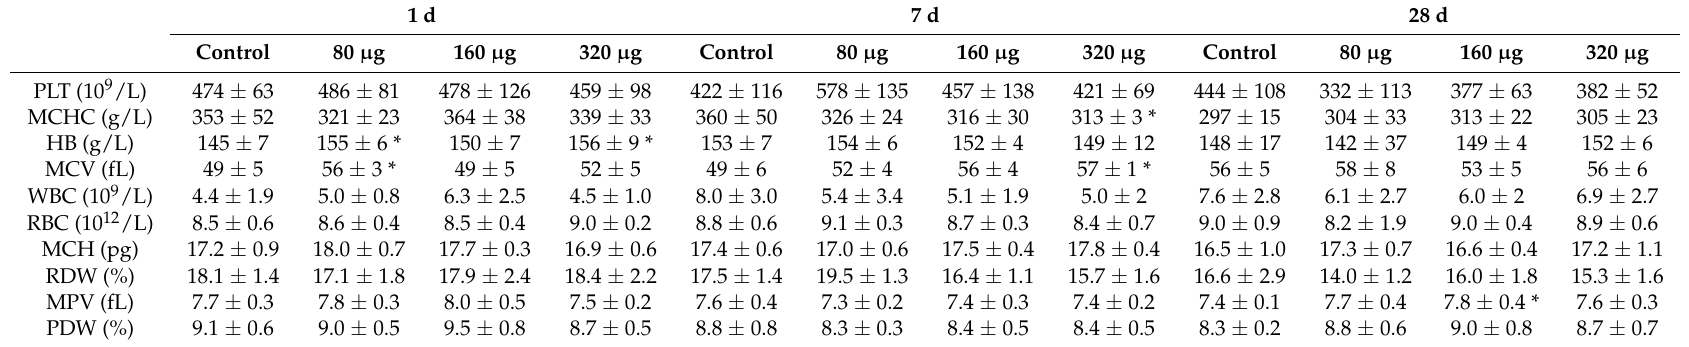
Table 2. Hematological parameters of the mice exposed to CNSI post intravenous exposure. Data represent means ± SD ( n =